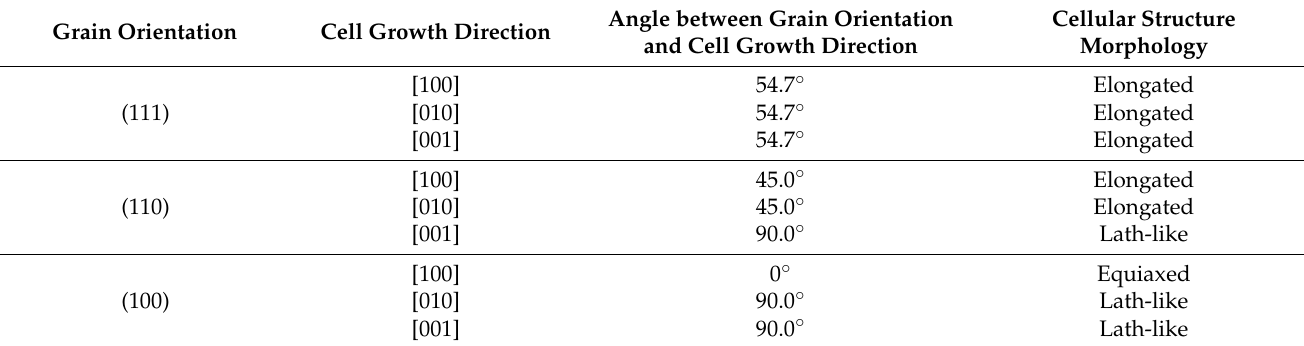
Table 1. Type classification according to grain orientation and cell growth direction.